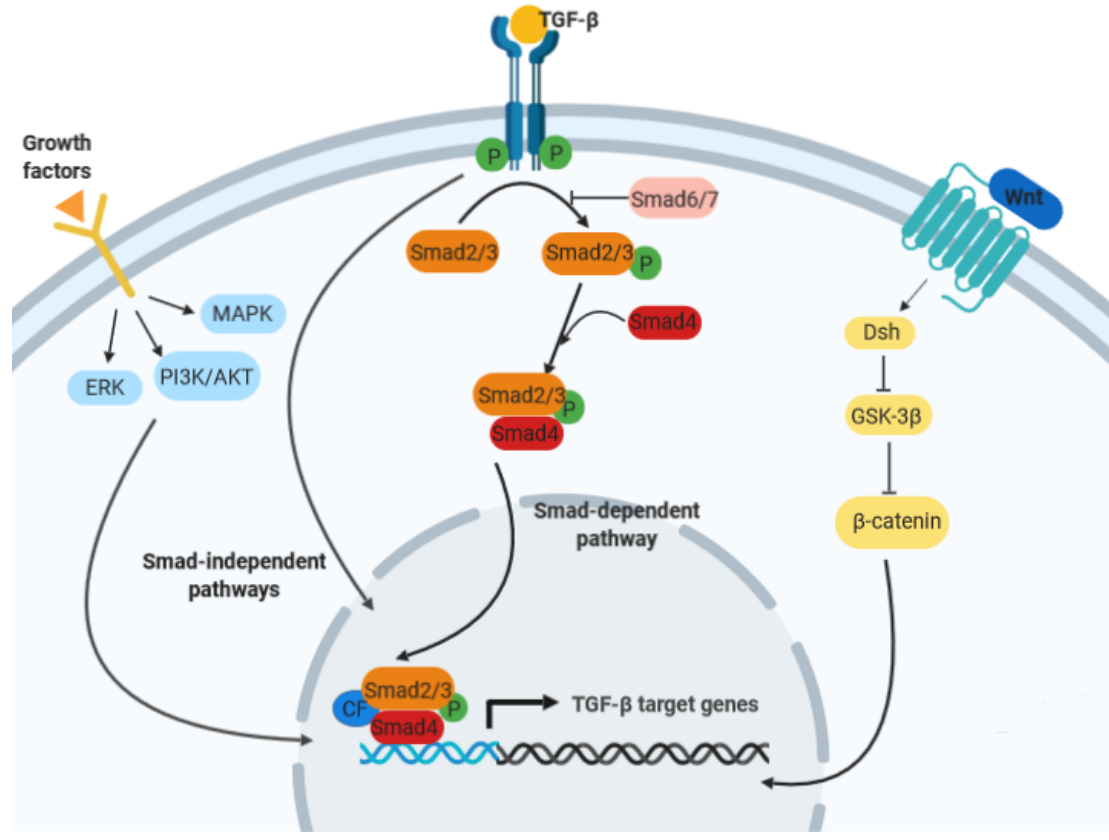
Figure 1. Schematic representation of the complex interactions involving TGF- β signaling and other important pathways in gastrointestinal tumors.